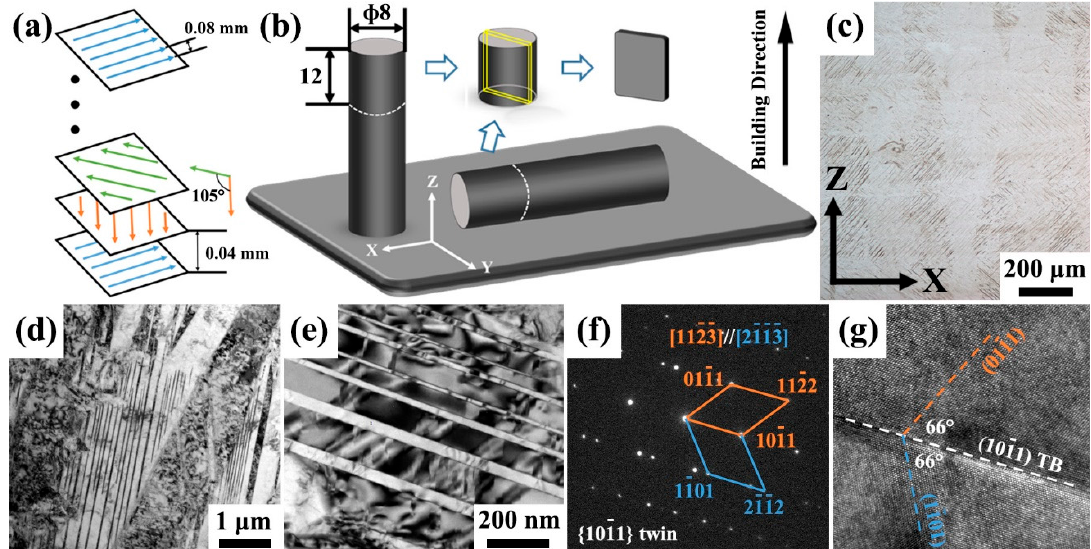
Figure 1. ( a ) SLM process illustration; ( b ) diagram of samples in different directions (unit: mm); ( c ) OM microstructure of the X–Z plane in an as-built sample; ( d – g ) {10-11} twins in an as-built sample via TEM observations.